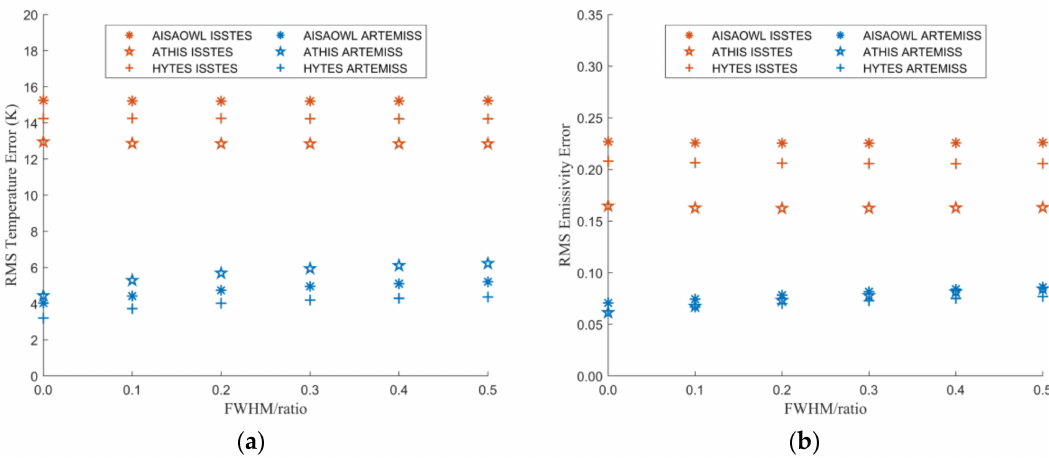
Figure 10. The graph of LST or LSE errors varying with the FWHM change ratio. The X axis is the FWHM change ratio, and the Y axis is LST error in ( a ) and is LSE error in ( b ).